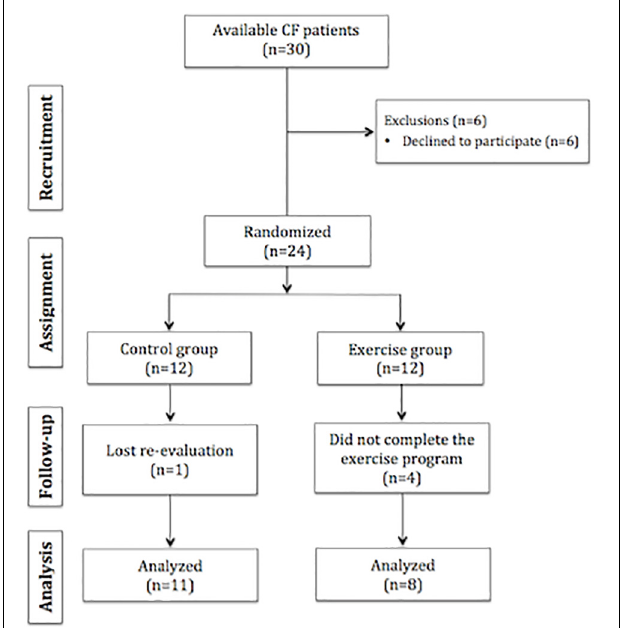
FIGURE 1 | Flow chart of the